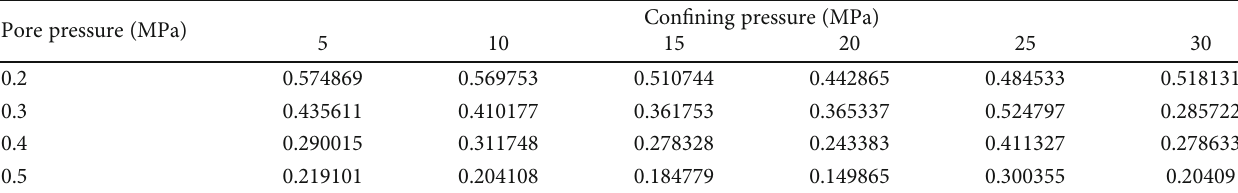
Table 6: Contribution rates of the gas slippage e ff ects (500 ° C).